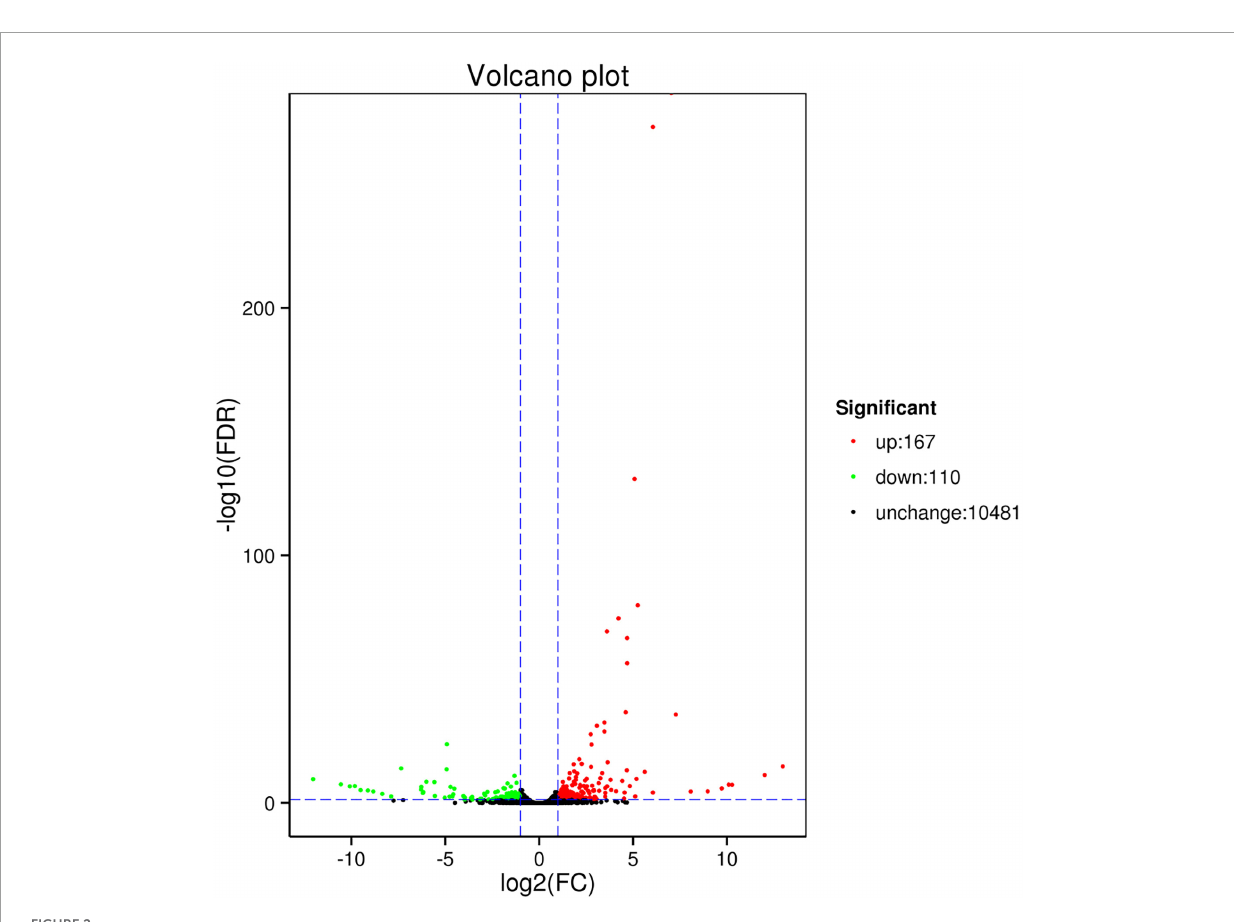
FIGURE2 Volcano plot of differentially expressed genes (DEGs) between control (CK) and high temperature